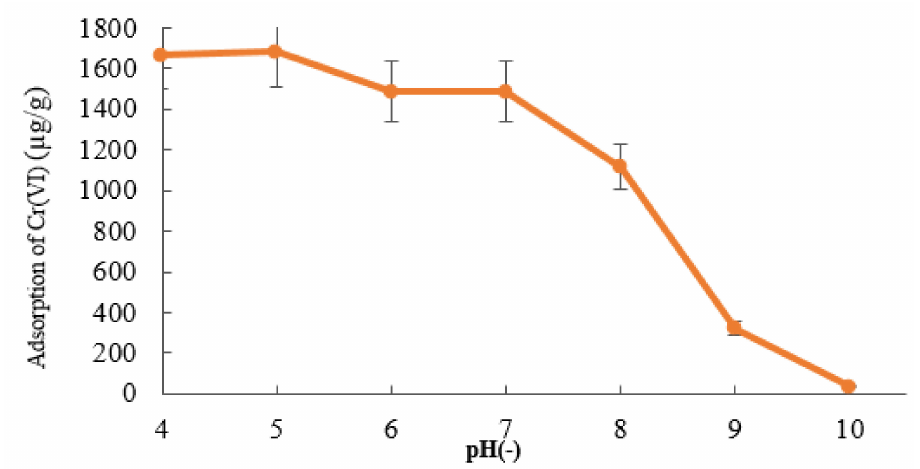
Figure 3. E ff ect of pH on the adsorption of Cr(VI) onto the SDS-modified chitosan